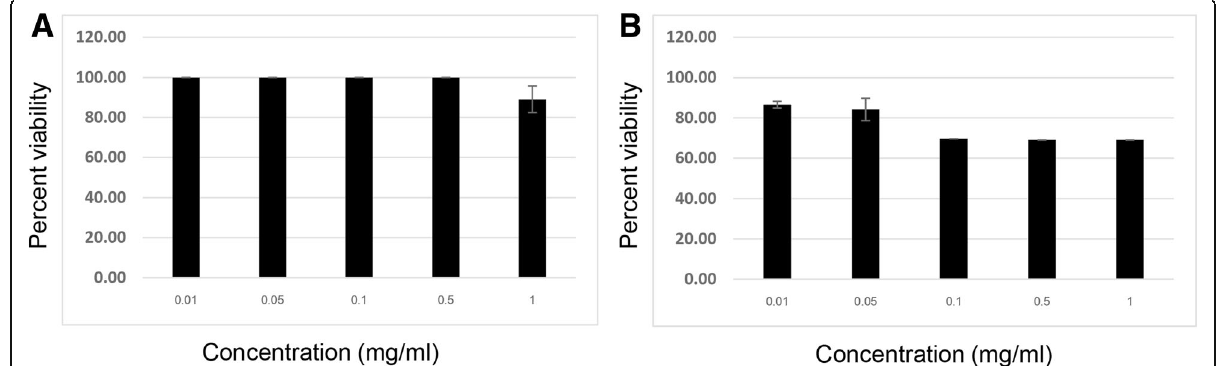
Fig. 1 Effect of PNEF ( a ) and PNWF ( b ) on the viability of HepG2 cells assessed by the MTT assay: Cells were treated with standard concentrations